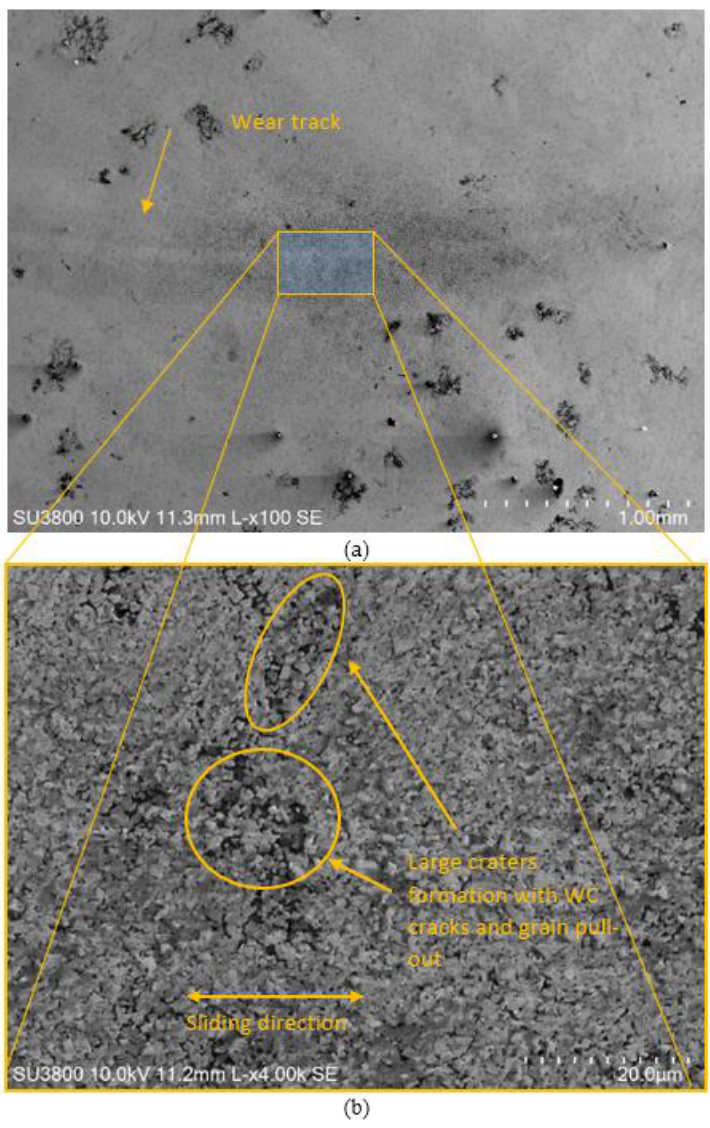
Figure 17. SEM micrographs of the wear track for the system WC-AISI 304/100Cr6 according to a magnification of: 100× ( a ), 4K× ( b ).